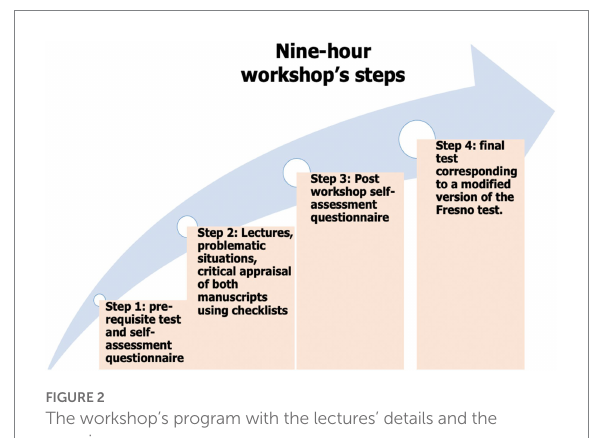
FIGURE 2 The workshop’s program with the lectures’ details and the